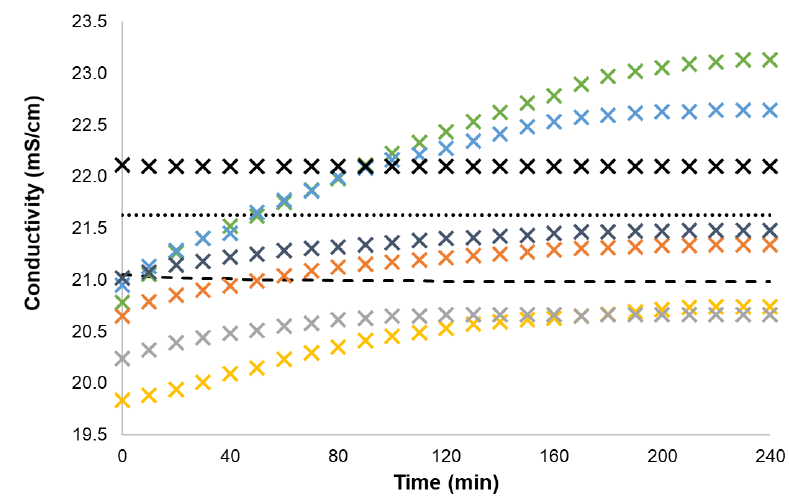
cross—IMC6, X orange cross—IMC8, X blue-gray cross—IMBENZ).